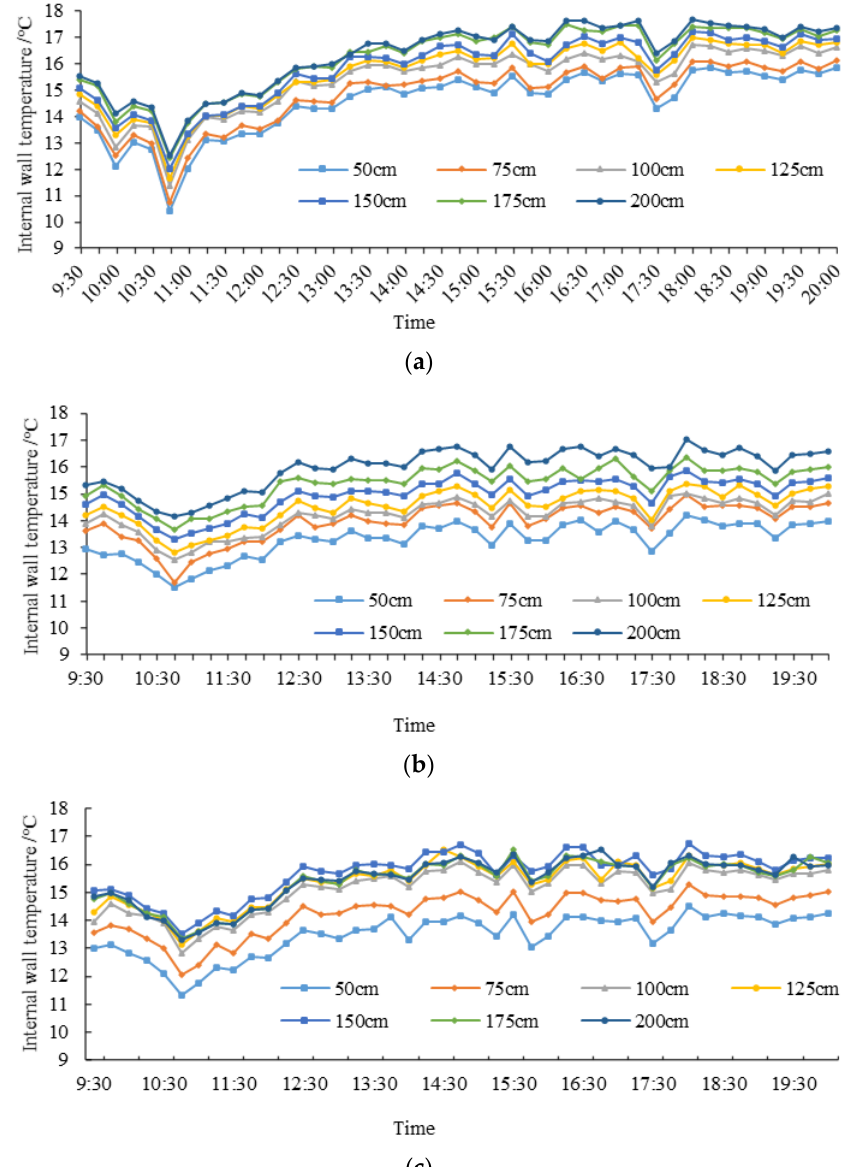
Figure 8. Variations in wall temperature at different locations with time: ( a ) east wall; ( b ) west wall; ( c ) North wall.